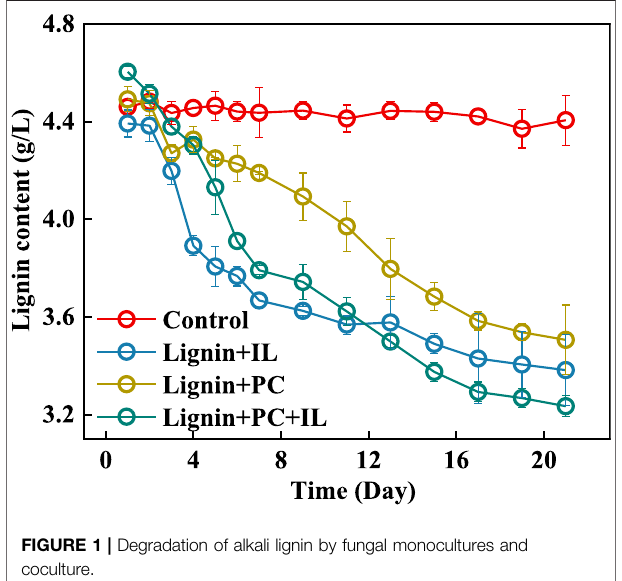
FIGURE 1 | Degradation of alkali lignin by fungal monocultures and coculture.